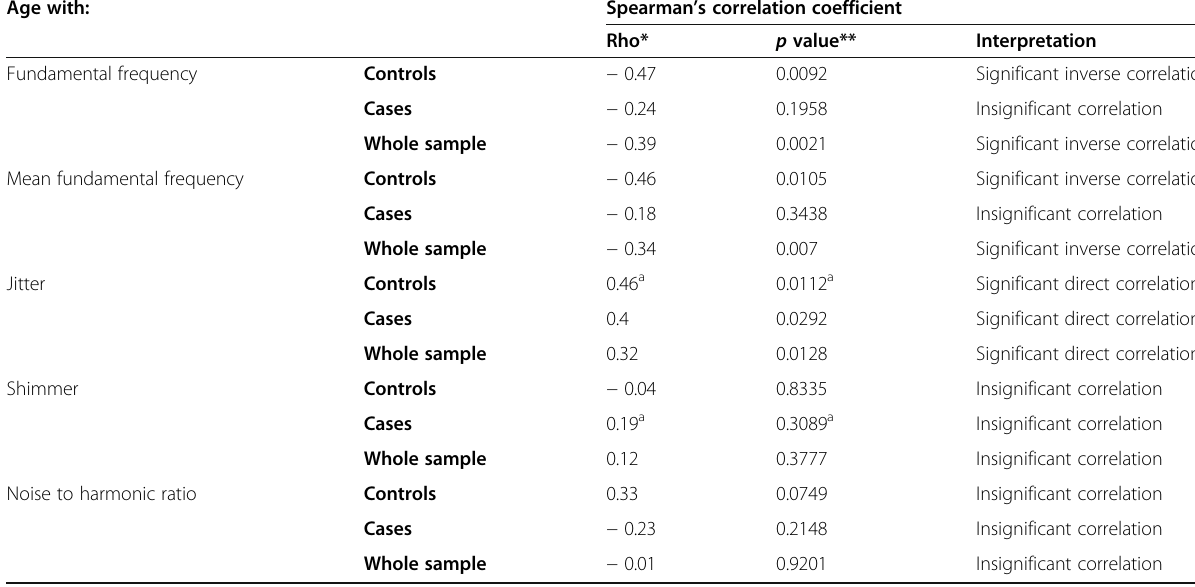
Table 5 Correlation analysis between the age and the numerical predictors in the study group Age